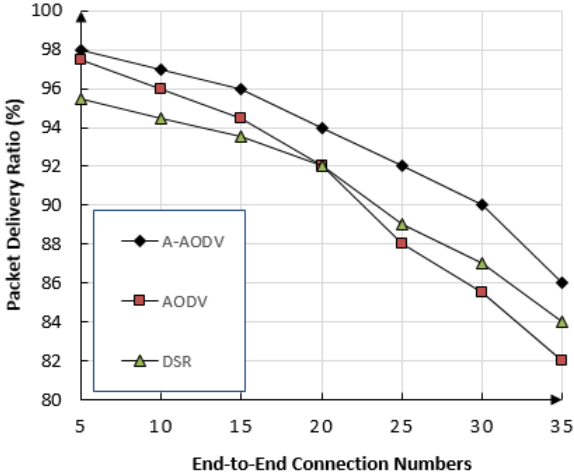
Figure 7. Packet Delivery